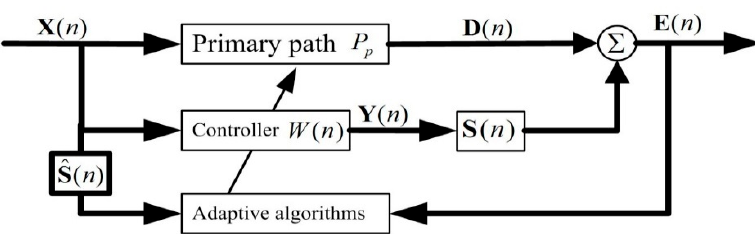
Figure 2. The diagram of the multi Filtered-x Least Mean Square algorithm